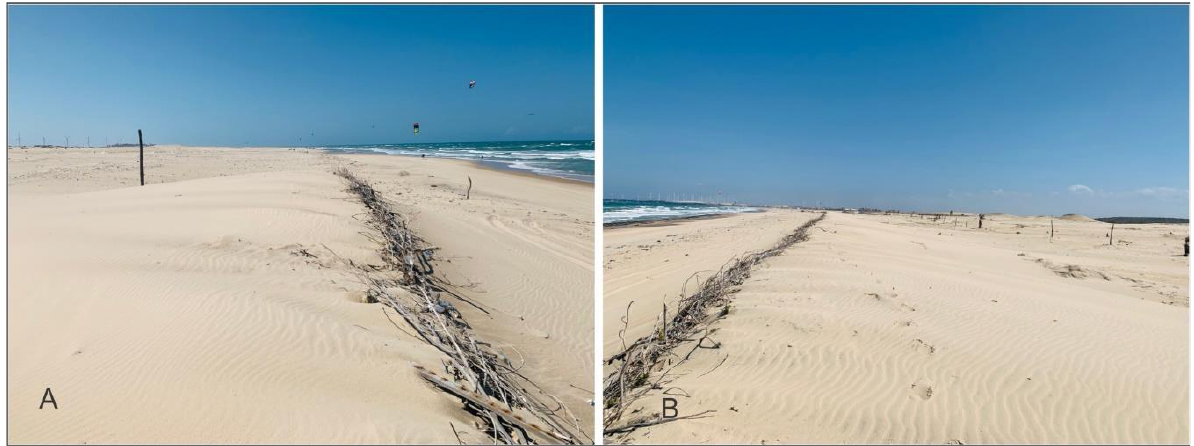
Figure 7. Distribution of branches and tree trunks parallel to the beach in the high tide strip with consequent development of foredune-like morphology with V-shaped crests oblique to the coastline. ( A ) Photographed in the west direction and ( B ) in the east direction. Taíba Beach.